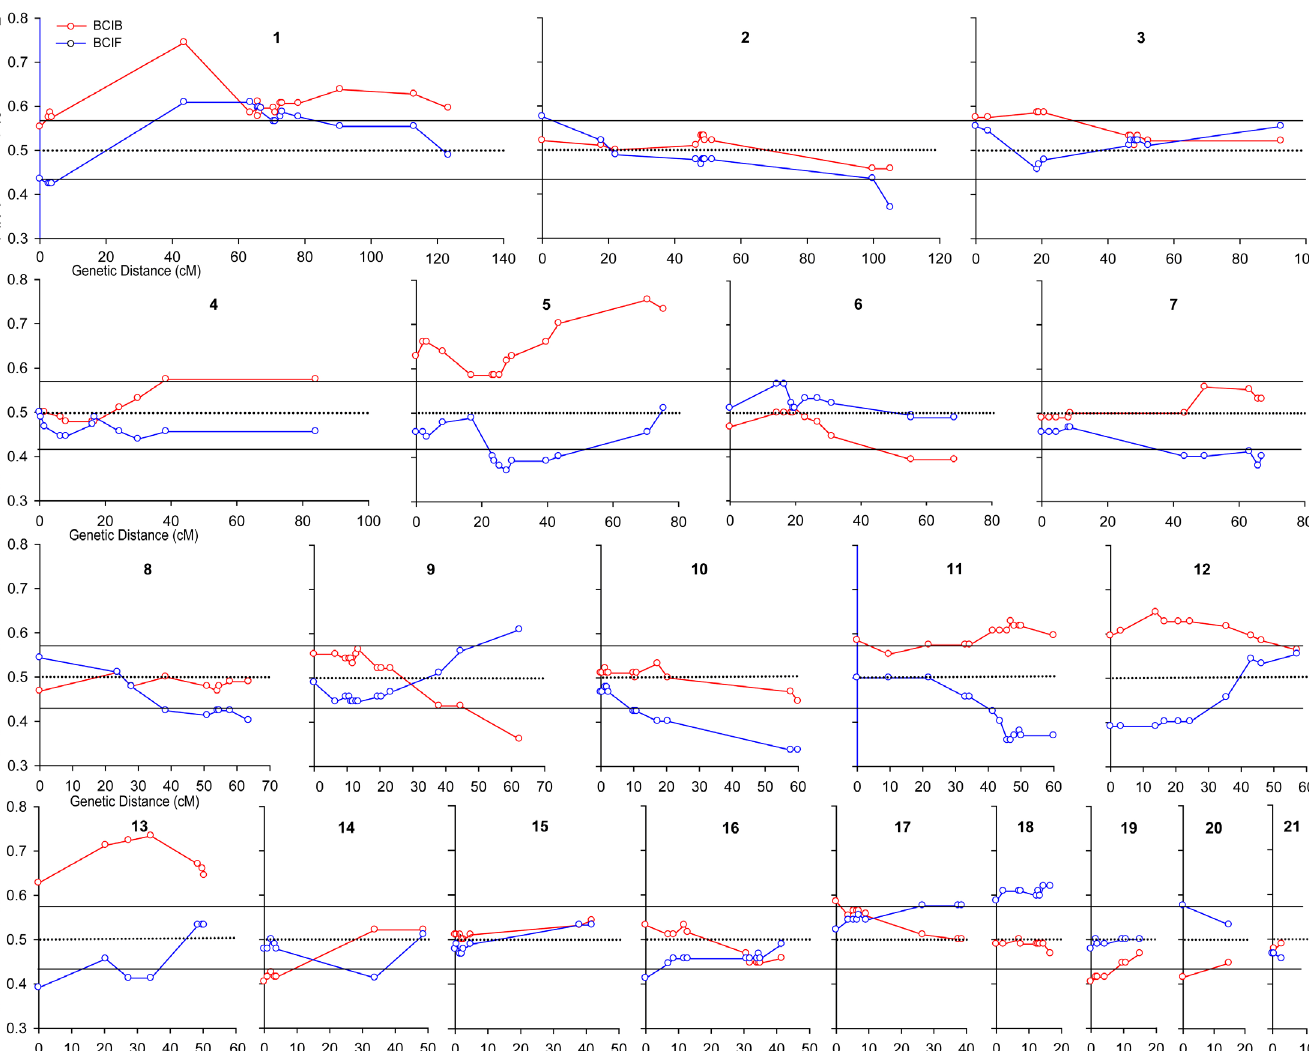
or I. brevicaulis (blue lines) into first generation backcross progeny formed from crosses between these two species. The X-axis indicates the genetic distances (in centimorgans) along each of the 21 linkage groups in the composite map. The Y-axis indicates the transmission ratio of either the I. fulva alleles or I. brevicaulis alleles introgressed into the backcrosses toward the alternate species. The expected frequency is 0.50 and is indicated by the dotted line. Data points above and below the solid lines indicate significant deviations from 0.50 ( α = 0.05). Frequencies > 0.50 indicate an overrepresentation of either the I. fulva (red line) or I. brevicaulis (blue line) alleles in the genetic background of the alternate species. Frequencies < 0.50 indicate an underrepresentation of these same categories